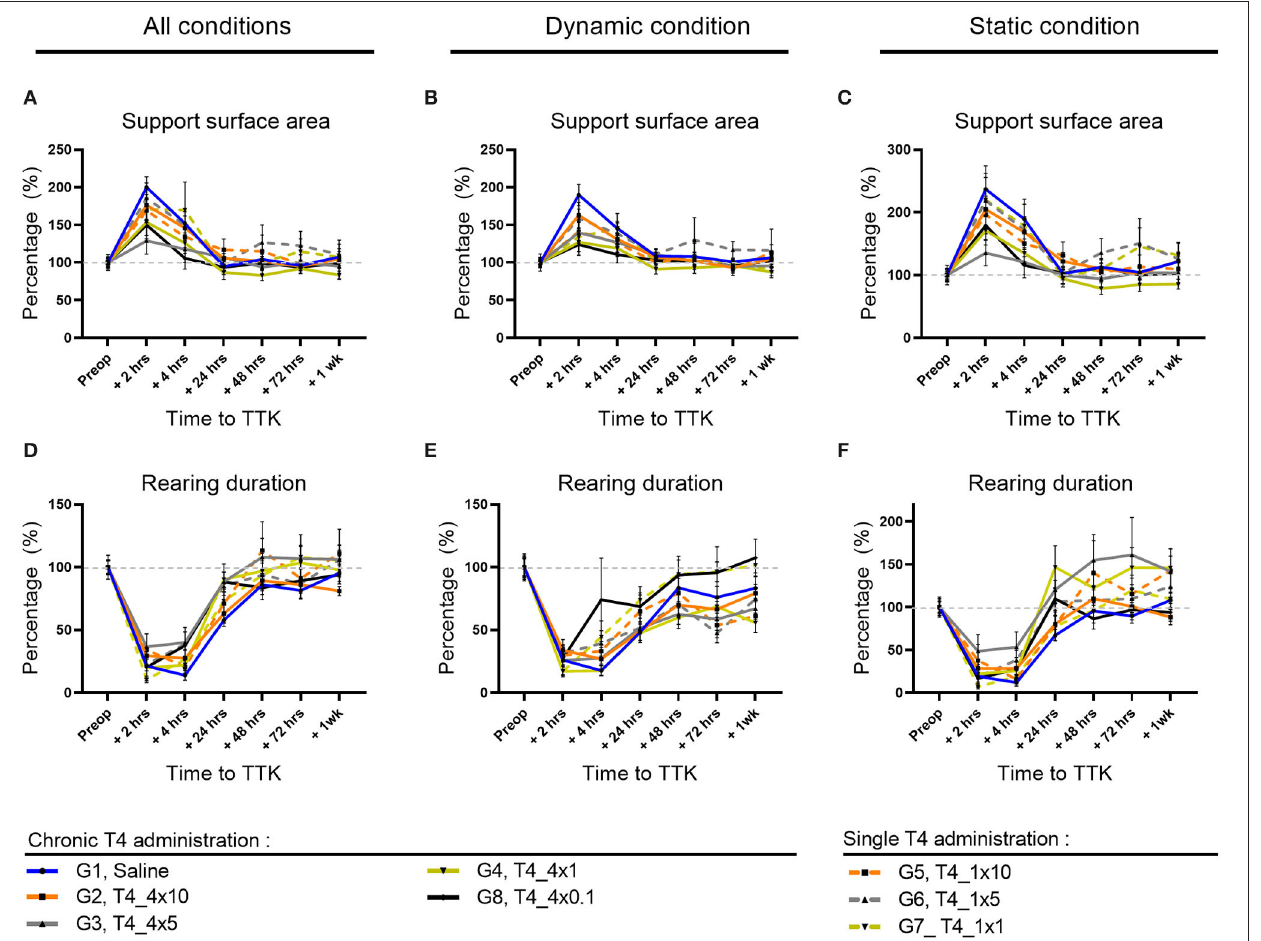
FIGURE 3 | Effect of T4 treatment on support surface area and rearing ability in vestibular defective rats. (A–C) Support surface area. (D–F) Rearing ability. T4 treatment shows no significant effect on any of the considered parameters (Two-way ANOVA, NS). n = 114.